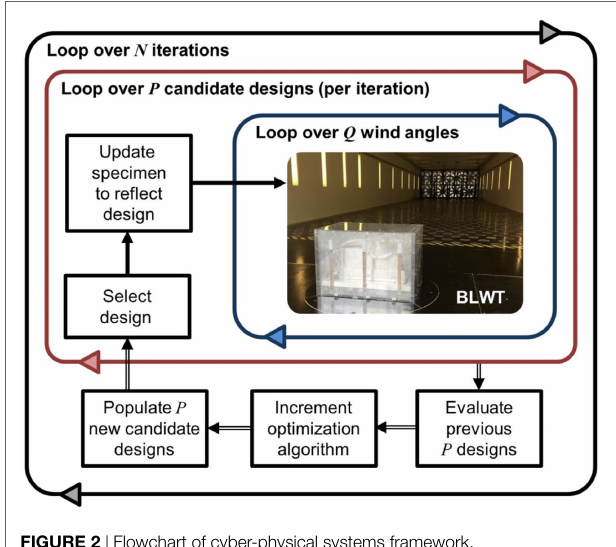
FIGURE 2 | Flowchart of cyber-physical systems